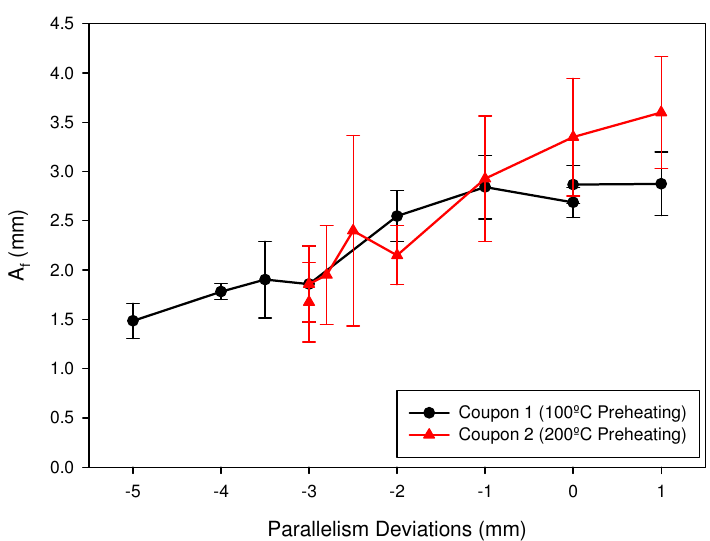
Figure 17. Length of the weld leg ( A f ) measured for the analyzed